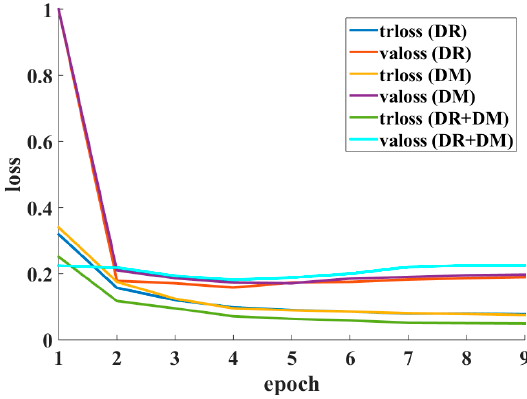
Figure 9. Loss curves of LIN trained with DR, DM and DR + DM. Table 3 listed the JA of single FCRN-88 trained on DR/DR + DM and our LIN evaluated on ISIC 2017 validation set. For comparison convenience, the frameworks only take a single scale